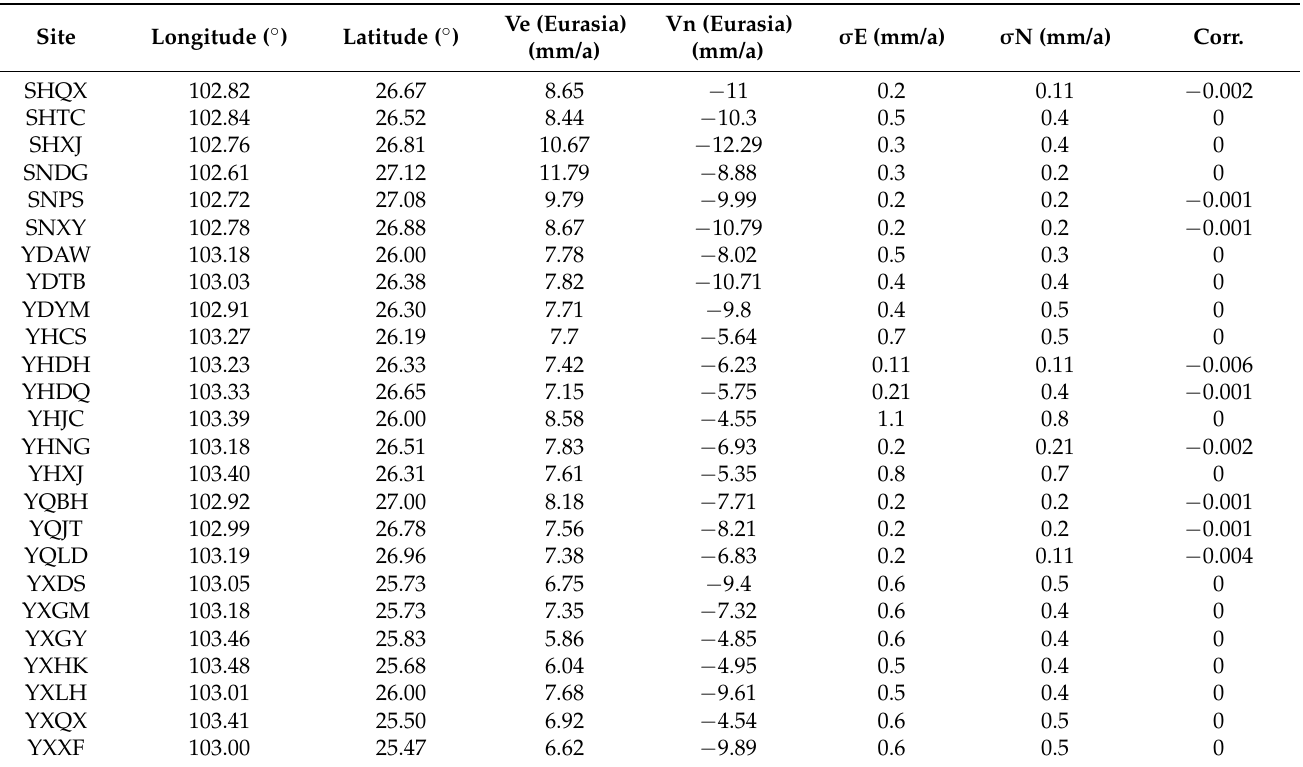
Table 1. Observed GNSS near-fault